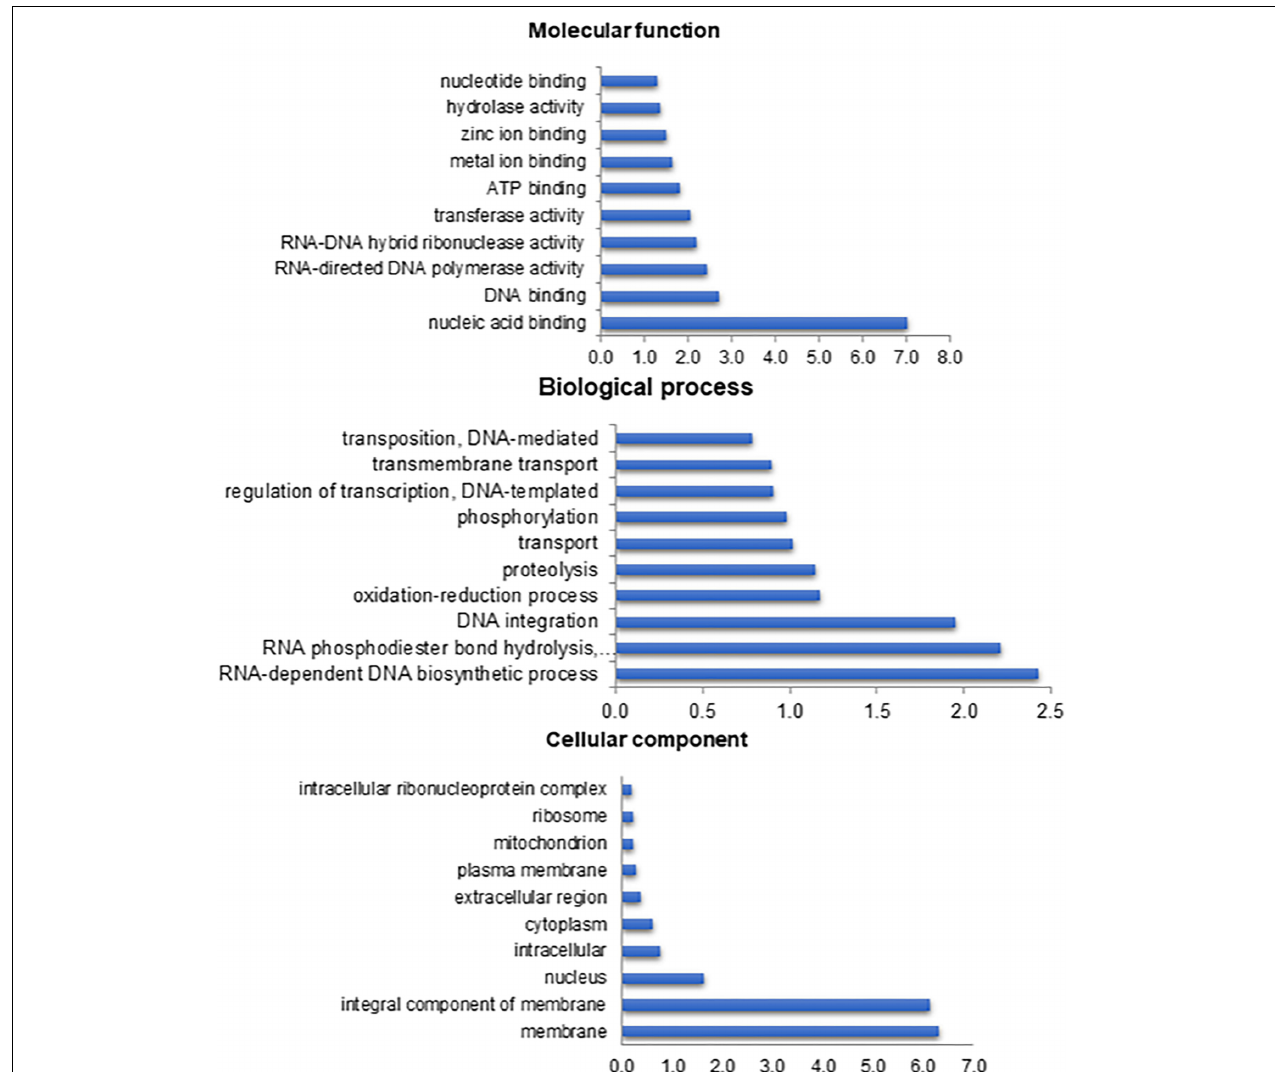
FIGURE 1 | Percentage of Anastrepha fraterculus contigs assigned to a certain gene ontology term as predicted by QuickGO from EBI. Top 10 terms are